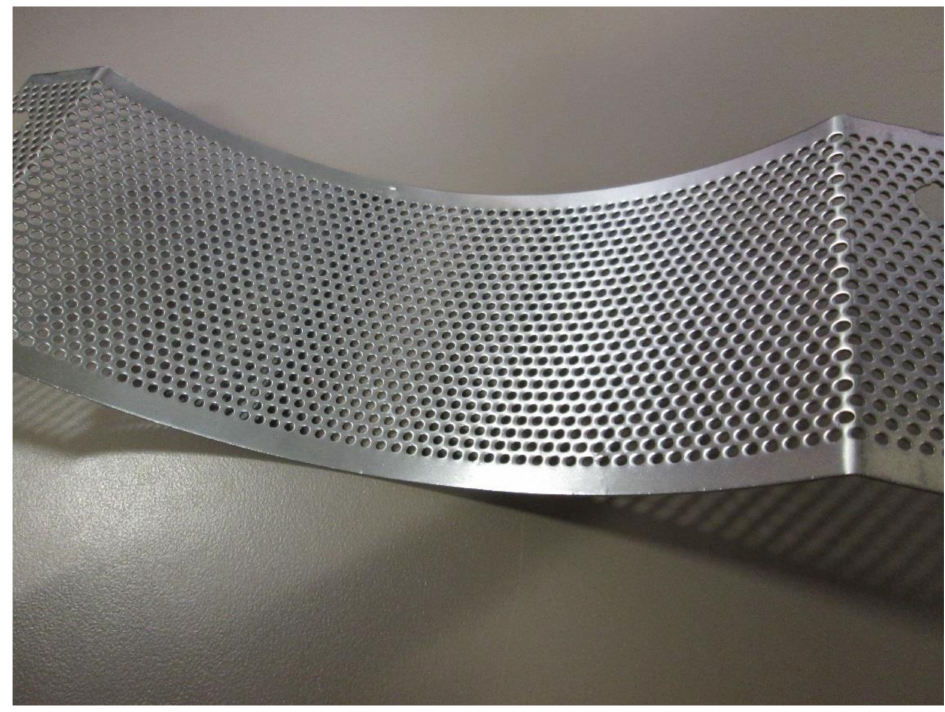
Figure 5. The two-mm screen used in the present study.